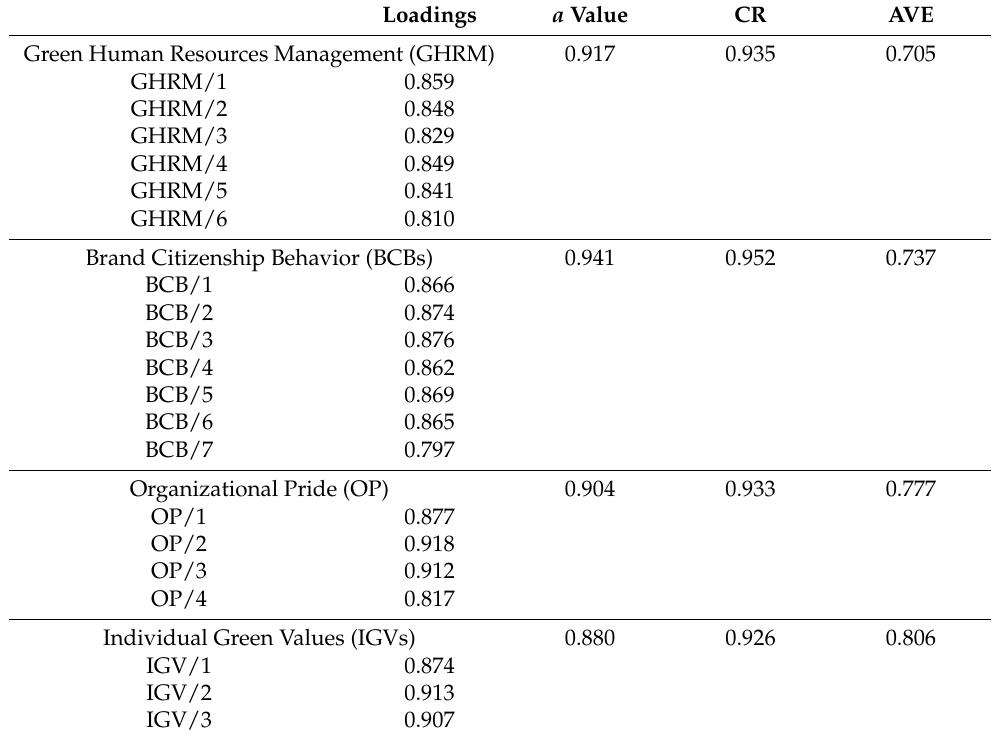
Table 1. Psychometric metrics.